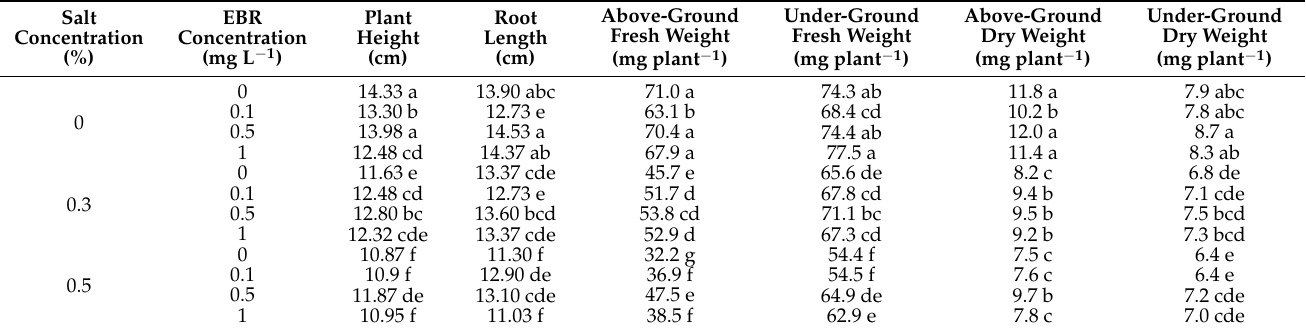
Table 3. Morphological traits and biomass of rice